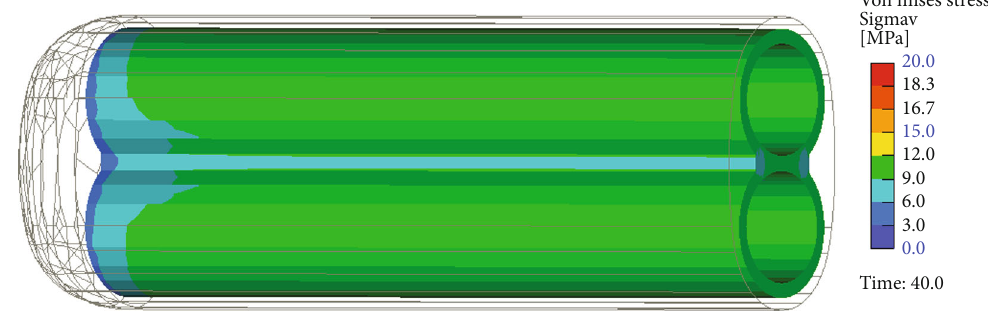
Figure 5: Von Mises stress distribution in tunica albuginea in normal condition. Case